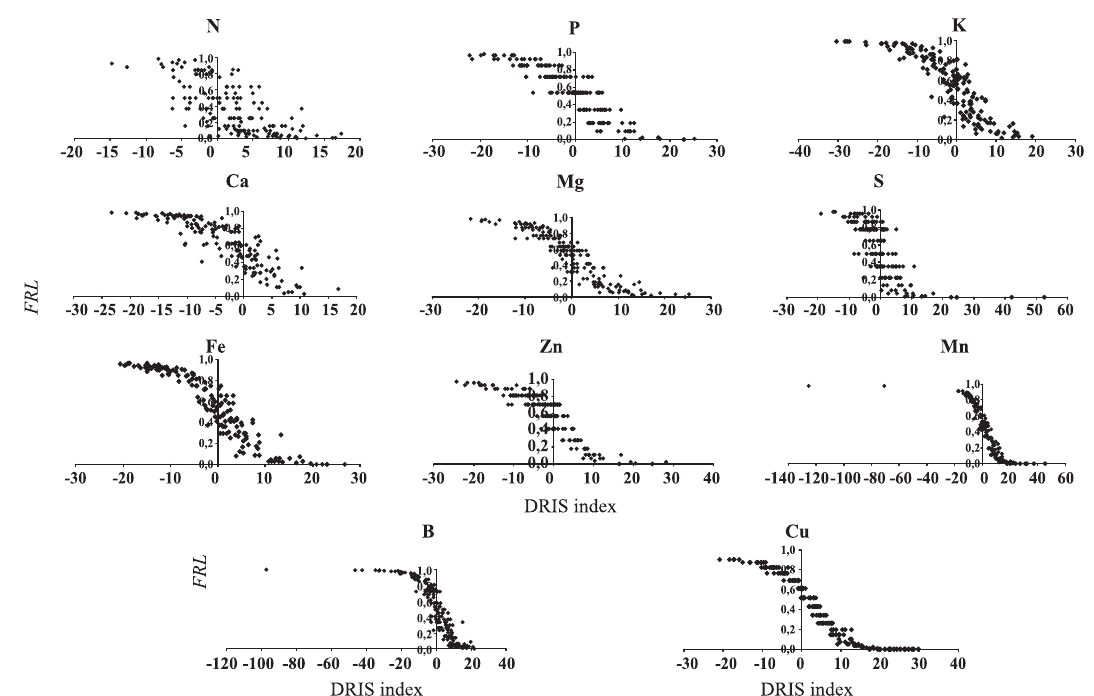
Figure 3. relationship between the dris index and the Fertilization response likelihood ( FRL ) for the nutrients evaluated